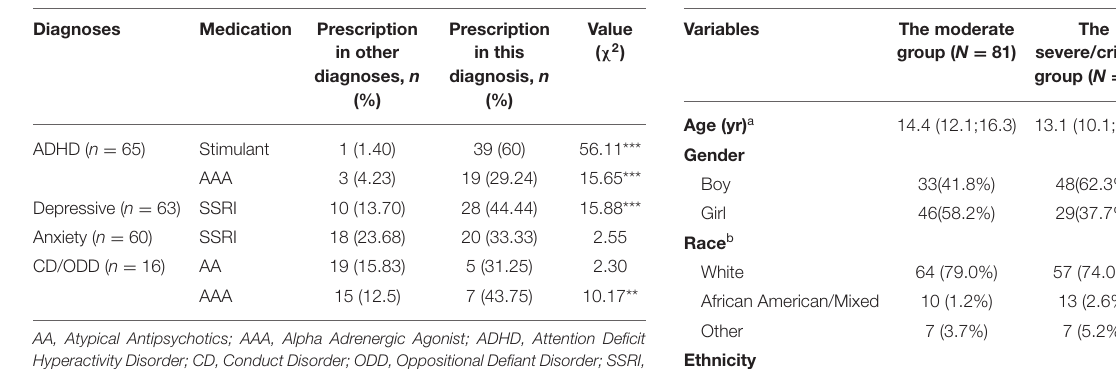
TABLE 2 | Cross tabulation of medication choices and categorical diagnoses ( N = 136).